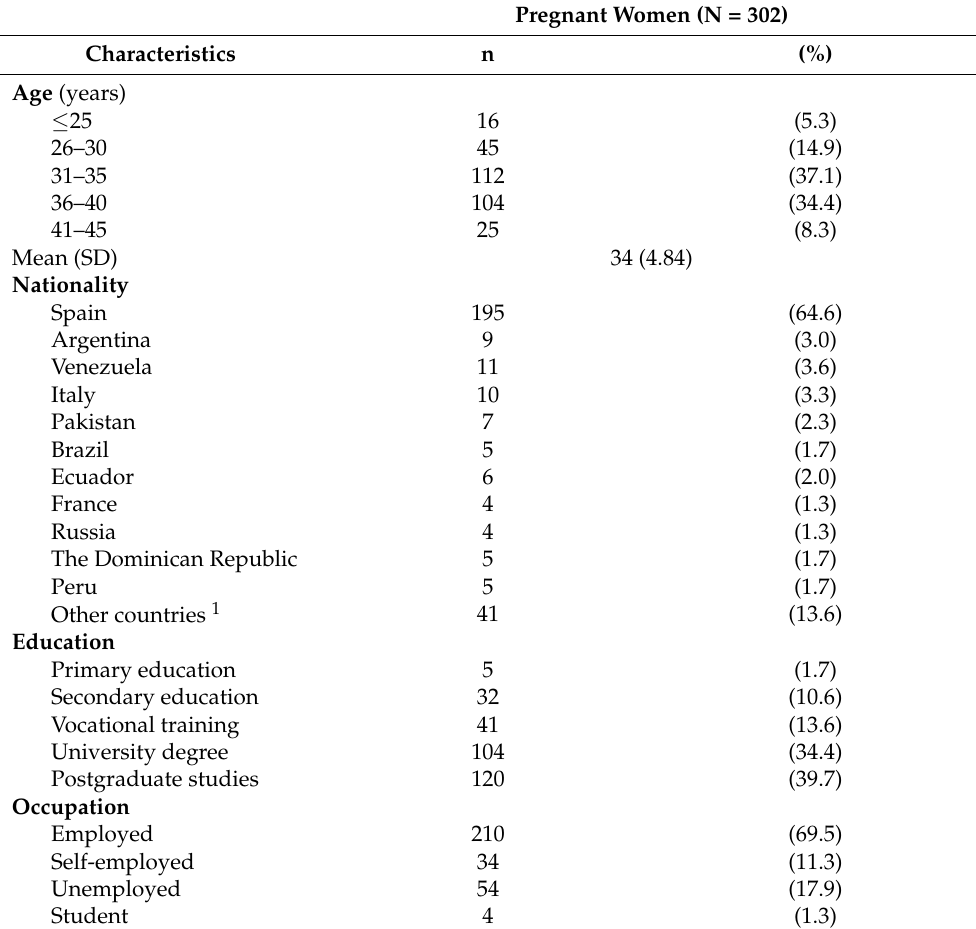
Table 1. Socio-demographic and obstetric characteristics of pregnant women at enrolment.